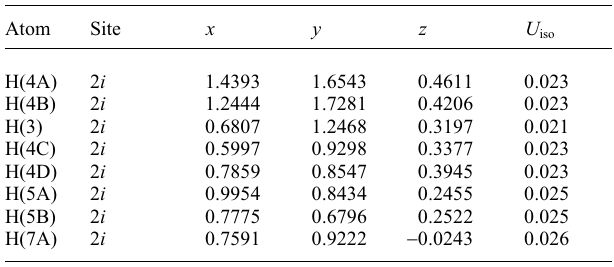
Table 2. Atomic coordinates and displacement parameters (in Å 2 )